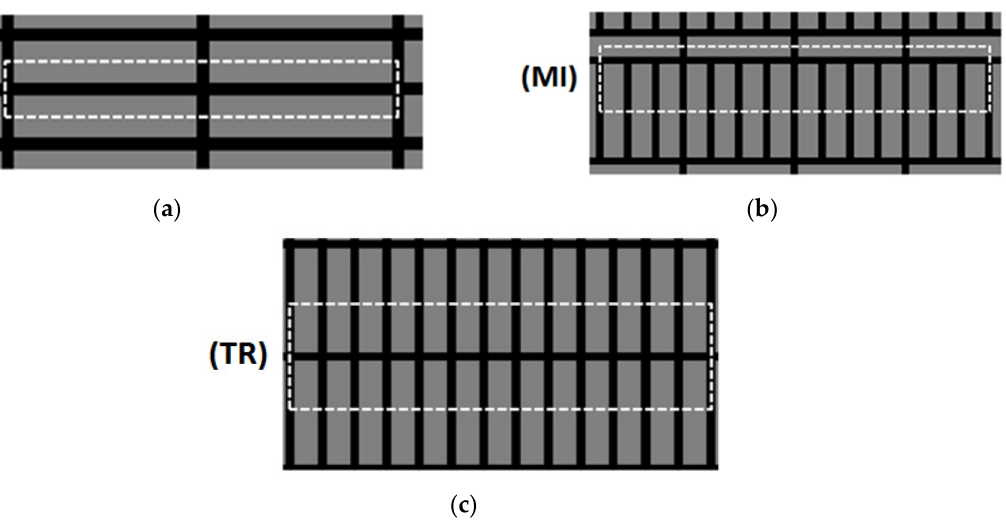
Figure 5. Elementary cells defined for the tested samples: ( a ) parallel (PA); ( b ) mixed (MI); ( c ) transverse (TR).